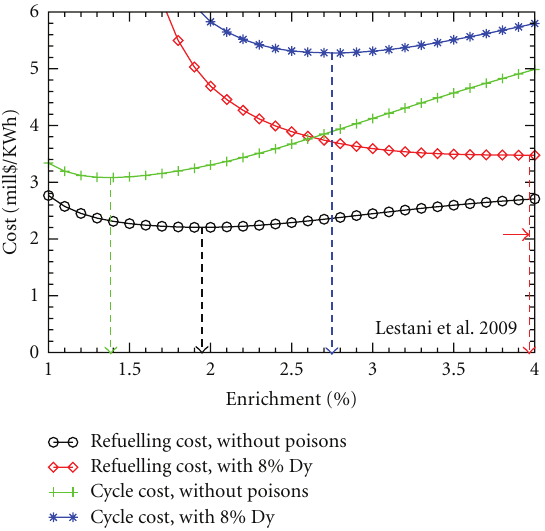
Figure 9: Fuel cost variation with UO 2